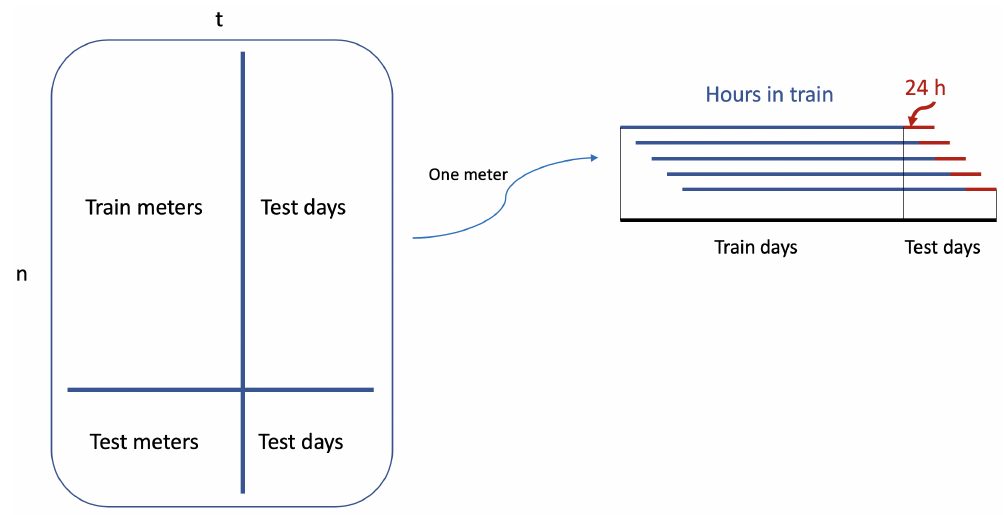
Figure 12. Scheme of out-of-sample evaluation along meters and time for each group and